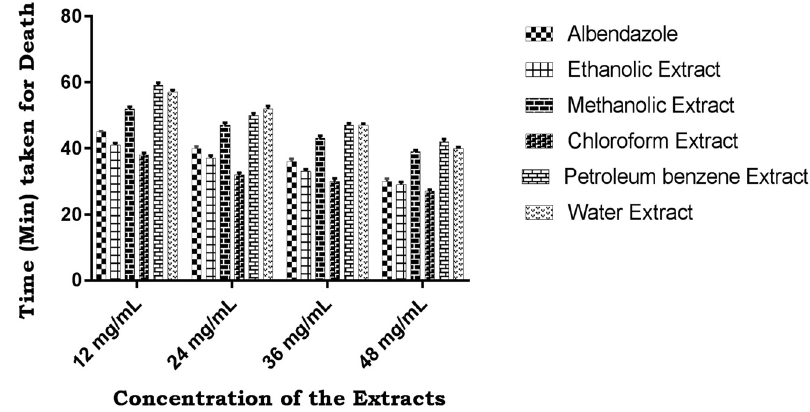
Figure 2: Mortality rate of P. posthuma treated upon D. viscosa